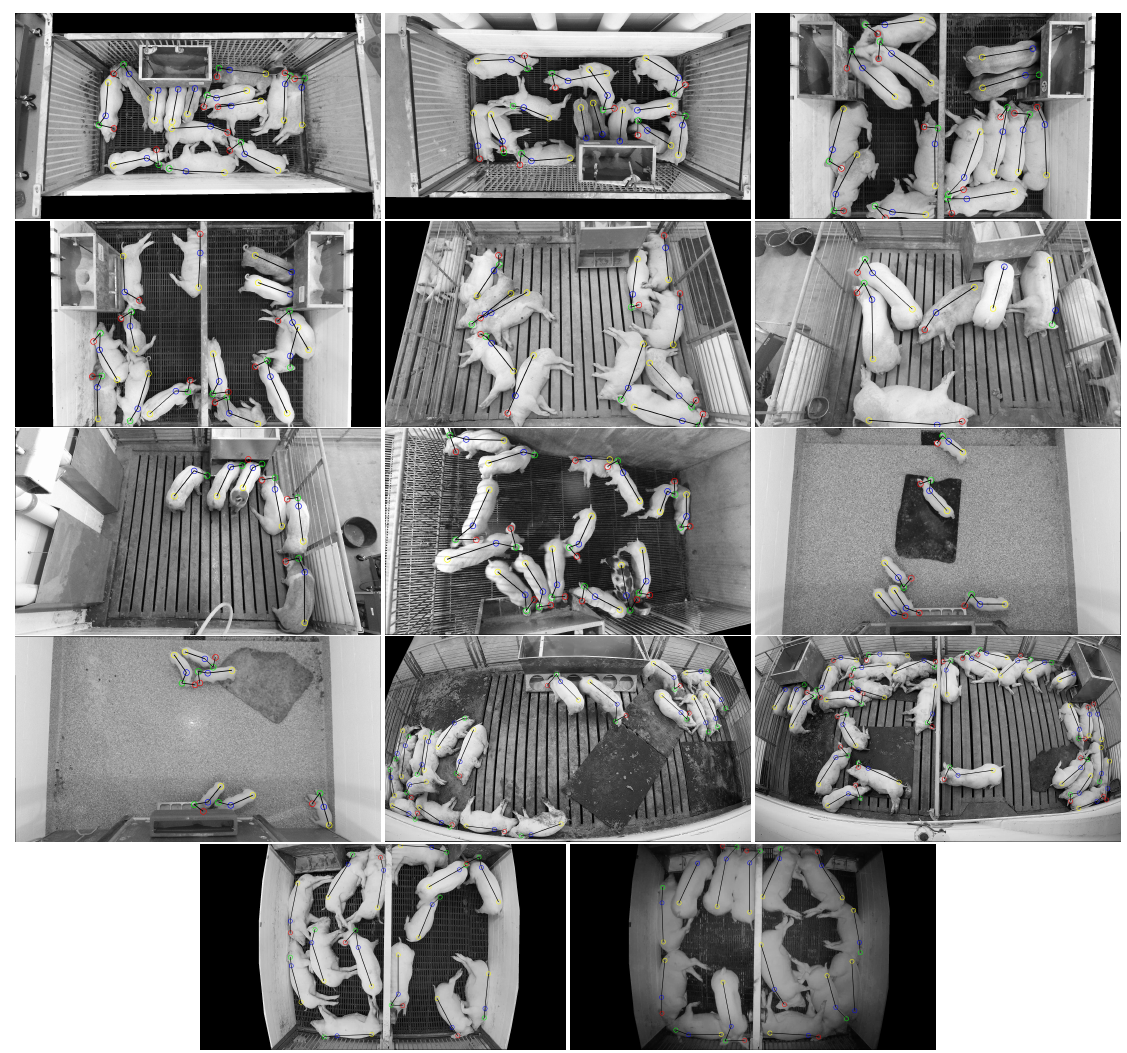
Figure 6. Sample images depicting different environments represented in the training set. The first 13 images (left-to-right, top-to-bottom) were captured during daylight hours with lights on. The last image (from the same environment as the 13th image) was captured using the infrared night vision mode used by the Lorex LNE3162B with active IR